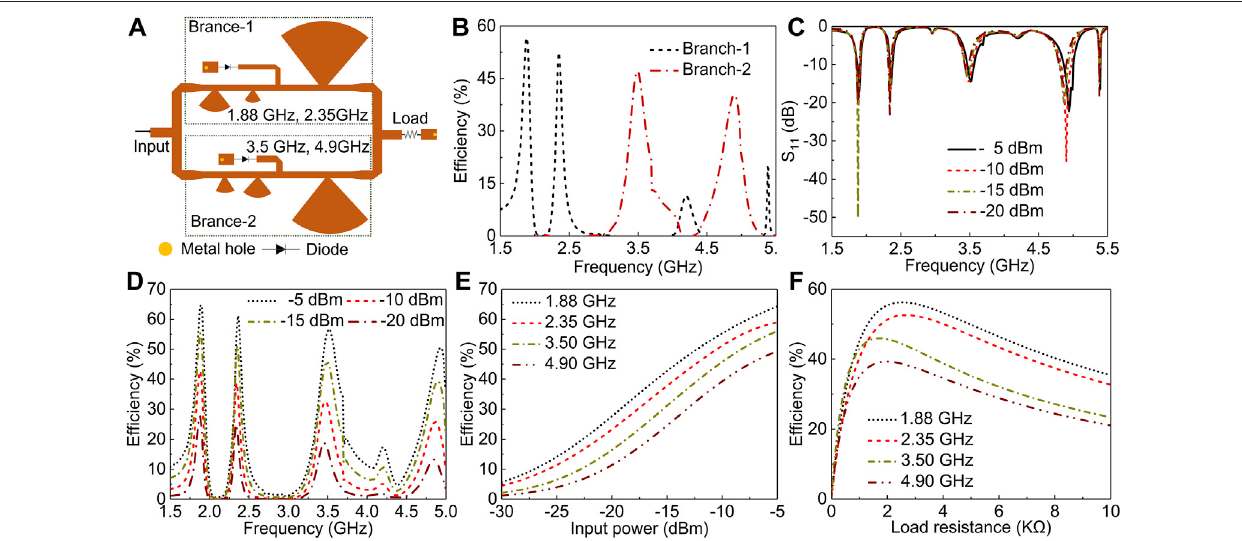
FIGURE1|(A) Thetopologyoftheproposedrecti fi er. (B) Simulated RF-DCconversion ef fi ciencyofthethreebranchesattheinputpowerlevelof − 10 dBm. (C,D) Simulatedre fl ectioncoef fi cientandRF-DCconversionef fi ciencyoftheproposedrecti fi eratdifferentinputpowerlevelsforaloadresistanceof2000 Ω . (E) SimulatedRF- DC conversion ef fi ciency of the proposed recti fi er versus input power level for a load resistance of 2000 Ω . (F) Simulated RF-DC conversion ef fi ciency of the proposed recti fi er versus load resistance at an input power of − 10 dBm.